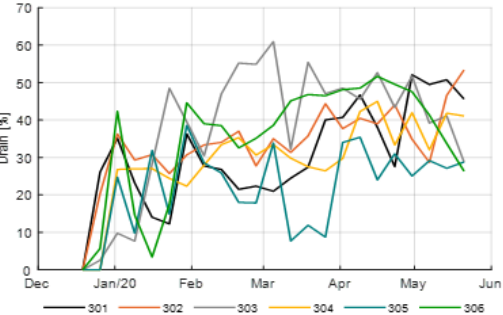
Figure 9. Weekly average of the daily amount of irrigation water (l/m 2 ) provided in the different greenhouse compartments (301–306).